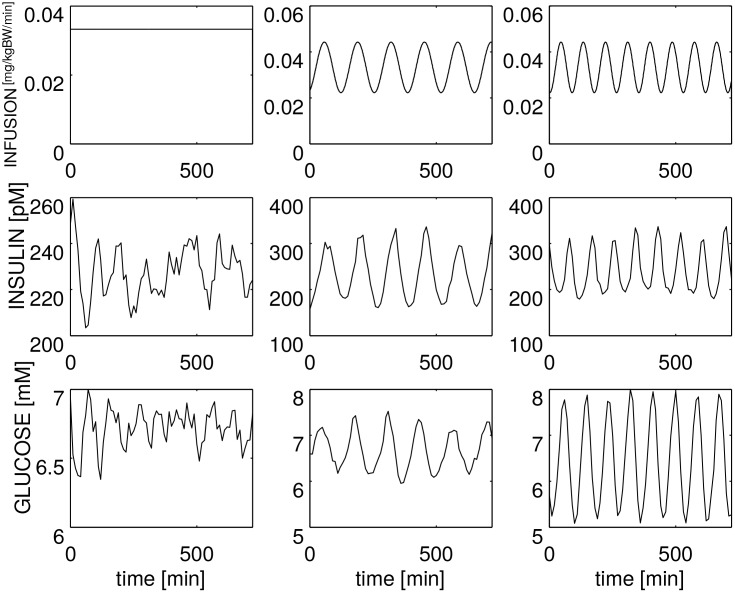
Glucose/insulin evolutions entrained by sinusoidal exogenous glucose administration.Glucose administration (top row), insulinemia (center row) and glycemia (bottom row) during a 720 min period. Compare this figure with Fig 1 by Sturis et al. [14].